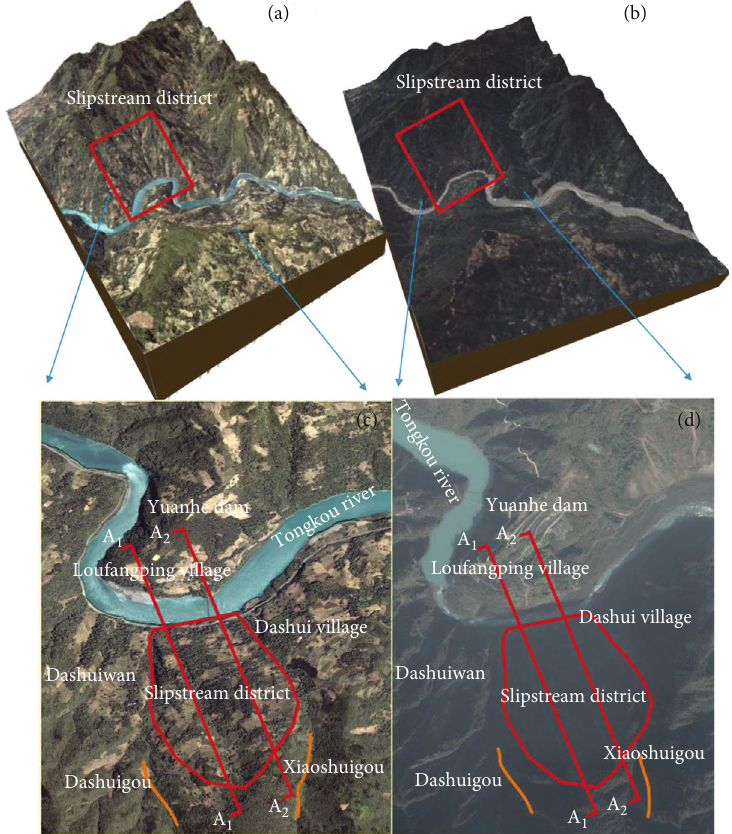
Figure 1: Comparison of the terrain before and after the landslide. (a) General view of the prelandslide terrain. (b) General view of the postlandslide terrain. (c) Enlarged view of the local topography before the landslide. (d) Enlarged view of the local terrain after the landslide.